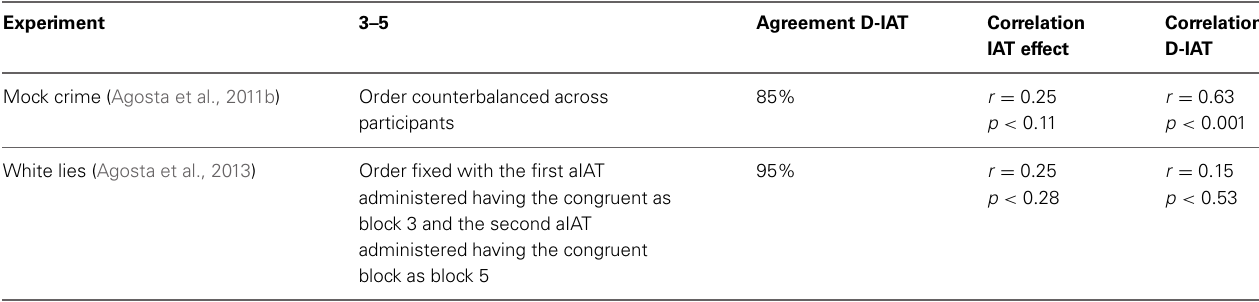
Table 3 | Correlation and agreement of D-IAT values and IAT effect for normal (congruent block in 3rd position and incongruent block in 5th position) and inverted (congruent block in 5th position and incongruent block in the 3rd position) orders. Experiment